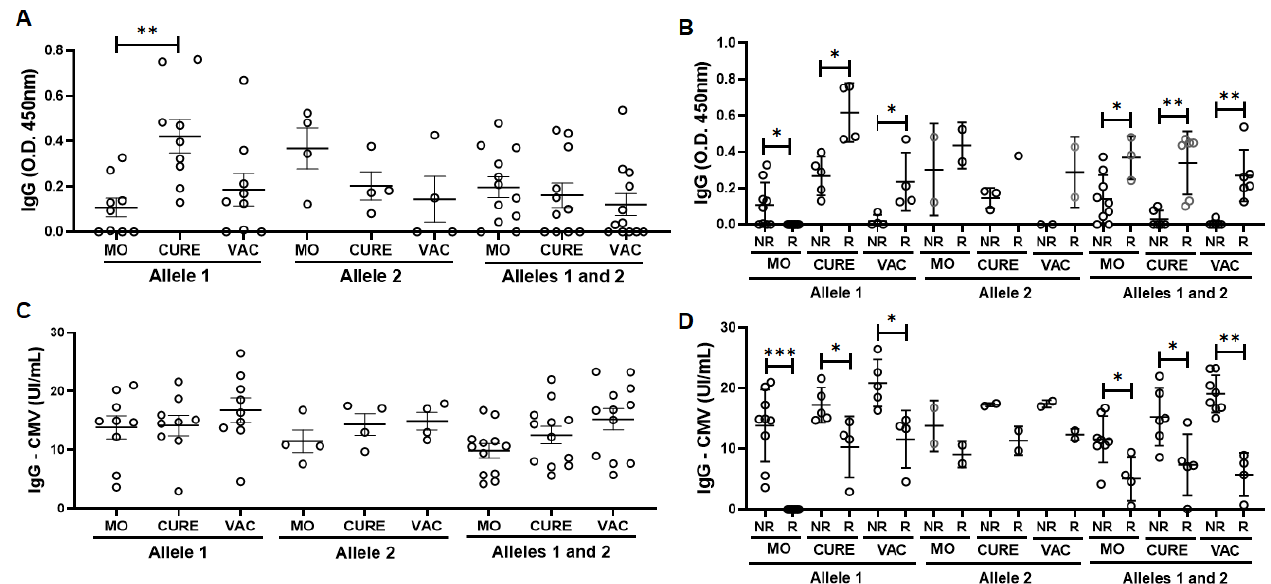
Figure 5. Total serum levels of IgG specific for SARS-CoV-2 (O.D. 450 nm, A ) and CMV (UI/mL, C ) antigens in the subgroups of volunteers grouped in accordance with the polymorphism in the IFN- lambda gene [allele 1 (C/C), allele 2 (T/T), and alleles 1 and 2 (heterozygous, C/T)], as well as these levels in the same subgroups of volunteers separated in accordance with the presence (R — respond- ers) or not (NR — non-responders) of neutralizing antibodies for SARS-CoV-2, respectively (SARS- (R—responders) or not (NR—non-responders) of neutralizing antibodies for SARS-CoV-2, CoV-2 — B and CMV — D ). * denotes values of p < 0.05; ** p < 0.01; *** p < 0.001.